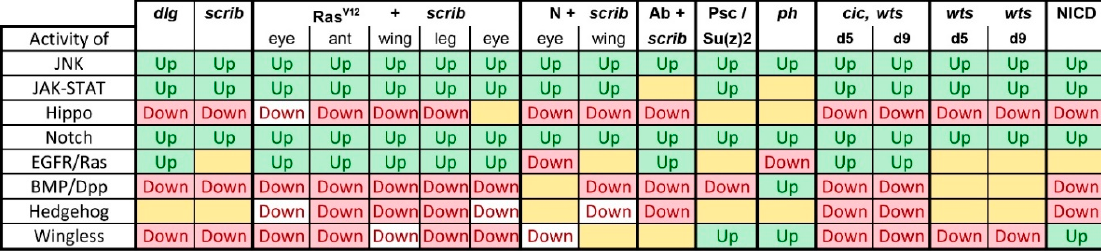
Figure 10. Overall summary of pathway activity across tumors. Yellow boxes indicate that the data were either inconclusive or there was no significant change in pathway activity based on target gene expression levels. White background indicates low confidence as the conclusion was based on a single data point.